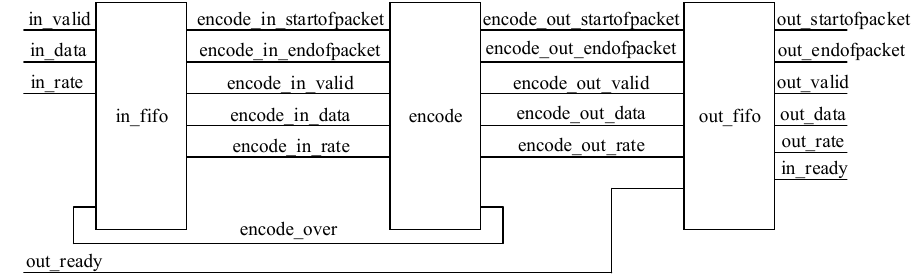
Figure 6. The hardware structure of the NB-QC-LDPC code encoder.